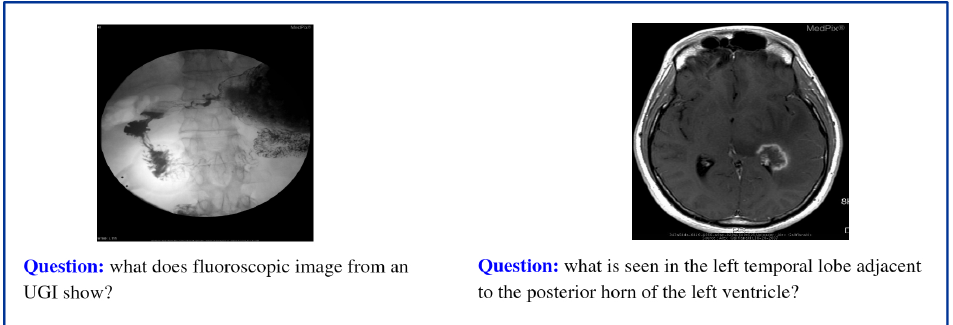
Figure 7. Example of radiology images and the associated questions from the VQG training set of ImageCLEF 2020